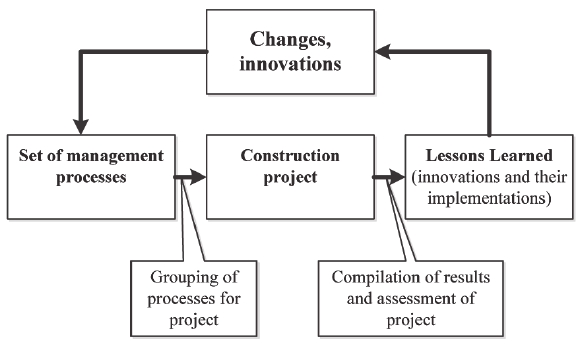
Fig. 7. a scheme of the process of acquiring